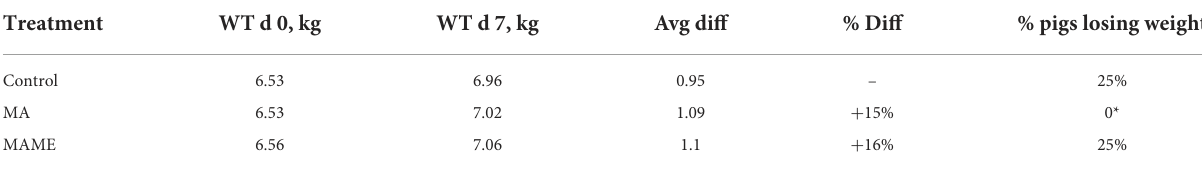
TABLE 4 Study 2 data showing that CON, MAME, MA did not differ significantly in body weights or ADG in this study. Treatment